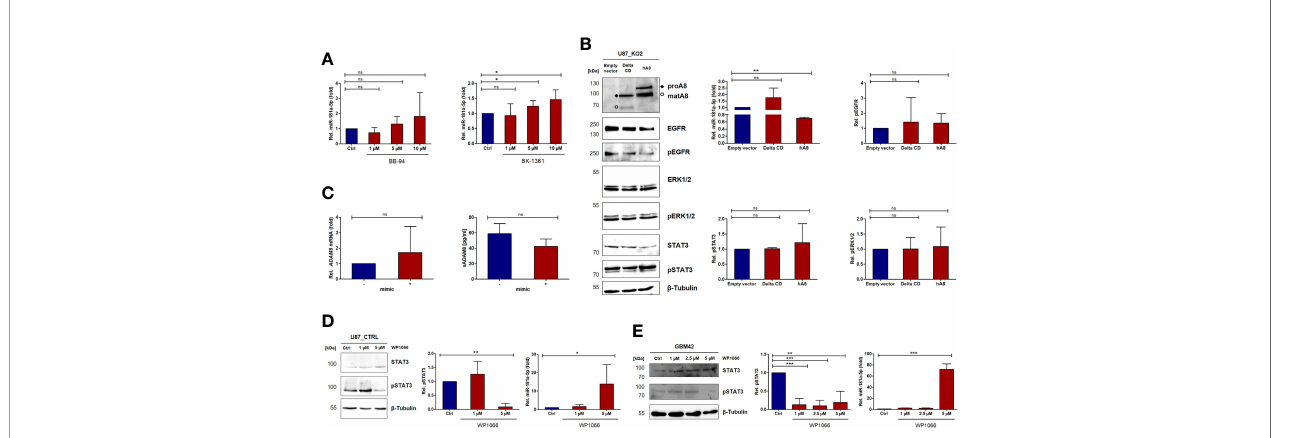
FIGURE 2 | ADAM8 regulates the expression of miR-181a-5p via JAK2/STAT3 signaling. (A) U87_CTRL cells were analyzed for miR-181a-5p expression by RT- qPCR after treatment with the broad-spectrum MMP inhibitor BB-94 (left) and the ADAM8 inhibitor BK-1361 (right). (B) One representative western blot of three independent experiments shows the rescue of either ADAM8 lacking the cytoplasmatic domain (Delta CD) or the full-length ADAM8 (hA8). The quanti fi cations of pEGFR, pSTAT3, and pERK1/2 are depicted on the right side and were normalized to b -Tubulin and total-EGFR/ b -Tubulin, total STAT3/ b -Tubulin, or total ERK1/2/ b - Tubulin. Also, RT-qPCR results show no differences in miR-181a-5p expression after the transfection of ADAM8 Delta CD but a downregulation with the full-length ADAM8 rescue (p-value: 0.002). (C) The expression of ADAM8 mRNA (RT-qPCR, left) and secreted ADAM8 (ELISA, right, n=2) is not affected after miR-181a-5p mimic transfection. U87_CTRL cells (D) and patient-derived GBM42 cells (E) were treated with JAK2/STAT3 inhibitor WP1066 as indicated and analyzed via western blot and RT-qPCR. In (D) , qPCR results are shown as mean values +/- SD of four independent experiments and in (E) , results of miR-181a-5p are described as mean values of three technical replicates. Inhibition of JAK2/STAT3 increases miR-181a-5p expression (U87 p-value: 0.027; GBM42 p-value: 0.004). Results are shown as mean values +/- SD from three independent experiments if not otherwise stated. Unpaired two-tailed students t-test was applied to determine signi fi cance: ns, not signi fi cant, *p < 0.05, **p < 0.01, ***p <